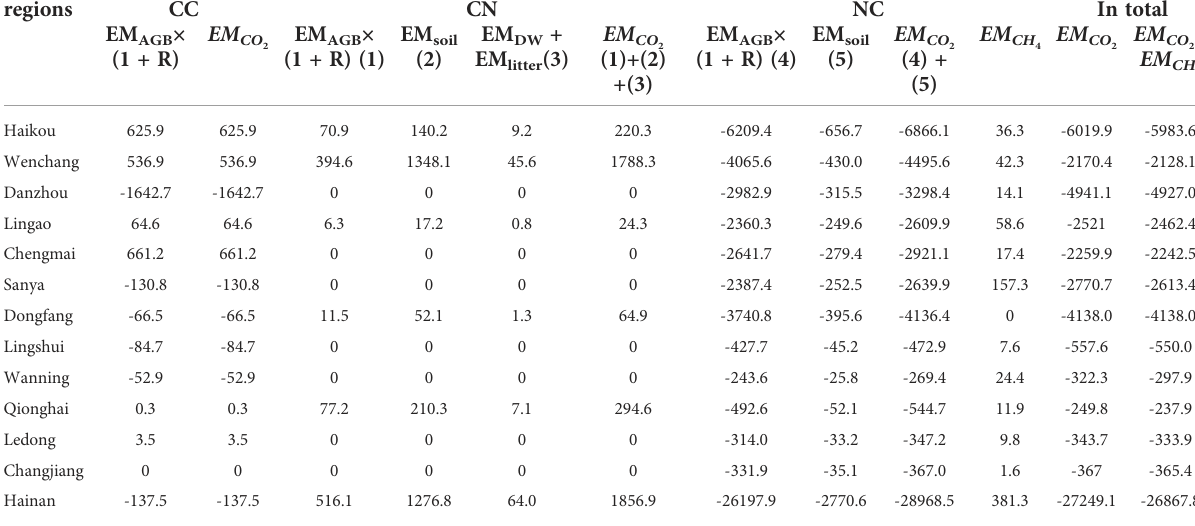
TABLE 4 The CO 2 and CH 4 inventory for mangroves in Hainan. Unit: MgCO2e yr-1. regions